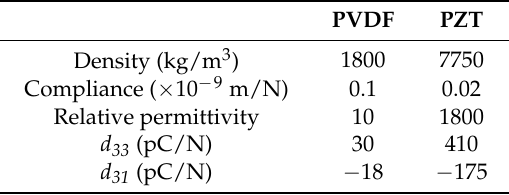
Table 1. Properties of PVDF and Lead Zirconate Titanate (PZT).